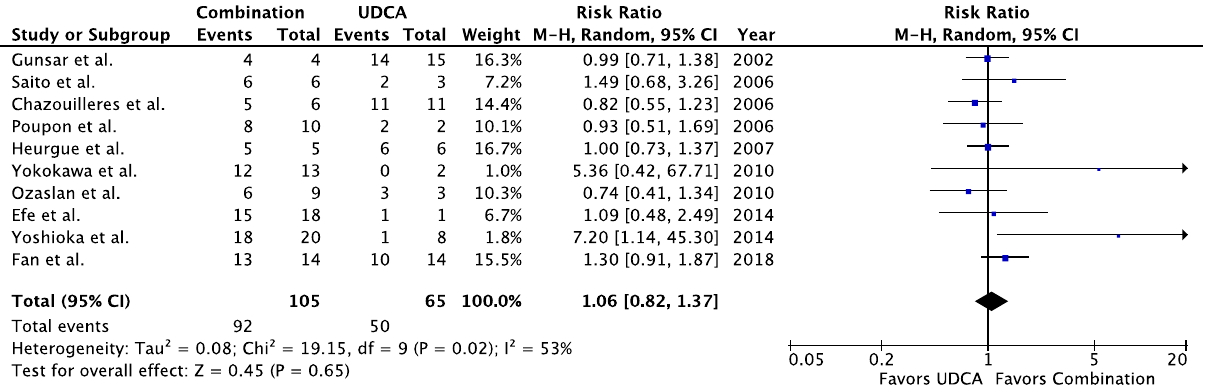
Figure 4. Transplant-free survival in AIH-PBC patients treated with combination therapy vs. UDCA alone. UDCA = ursodeoxycholic acid, Combination = UDCA + [corticosteroids and/or antimetabolites].